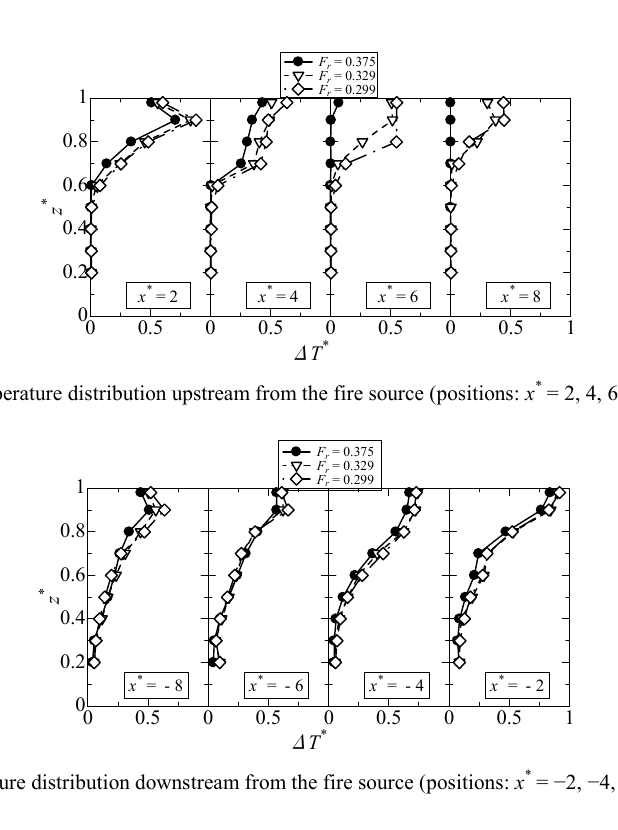
Fig. 8 Rise in temperature distribution in the direction of the height in four different positions in the case of Q * m =